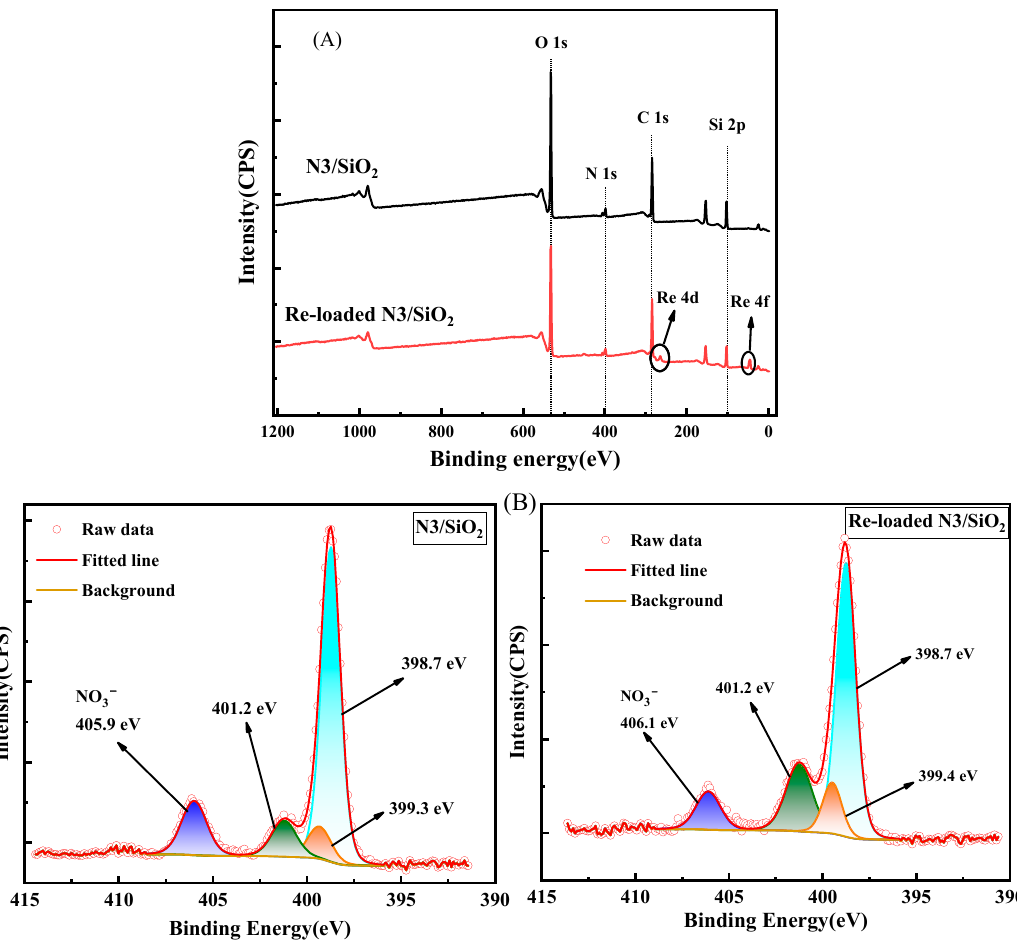
Figure 5. ( A ) Wide XPS spectra of N3/SiO 2 and Re-loaded N3/SiO 2 ; ( B ) High resolution XPS spectra of N 1s in N3/SiO 2 and Re-loaded N3/SiO 2 .